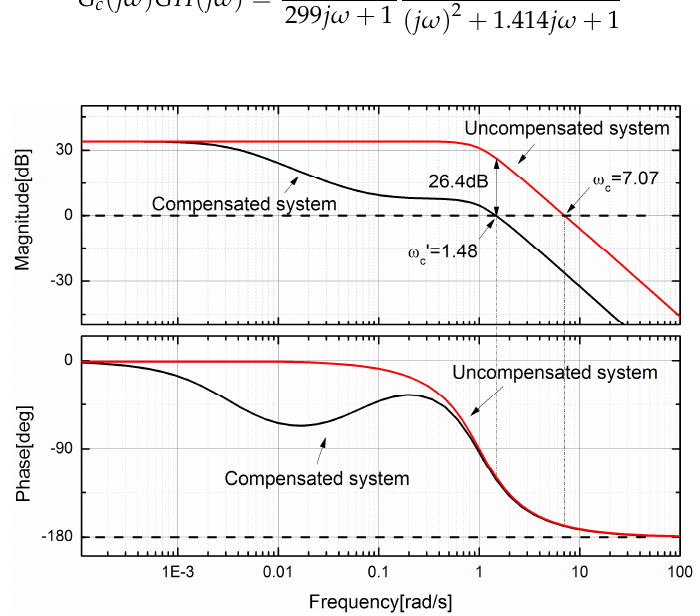
Figure 7. Design of the phase-lag network on the Bode diagram.